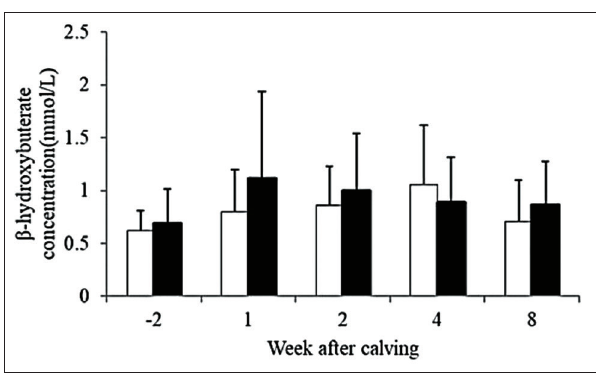
Figure-5: Dynamics of serum β-hydroxybutyrate concentration at 2 weeks before expect calving date and 1, 2, 4, and 8 weeks after parturition of smallholder (□, n=15) and semi-commercial ( , n=17), error bars stand for standard ■